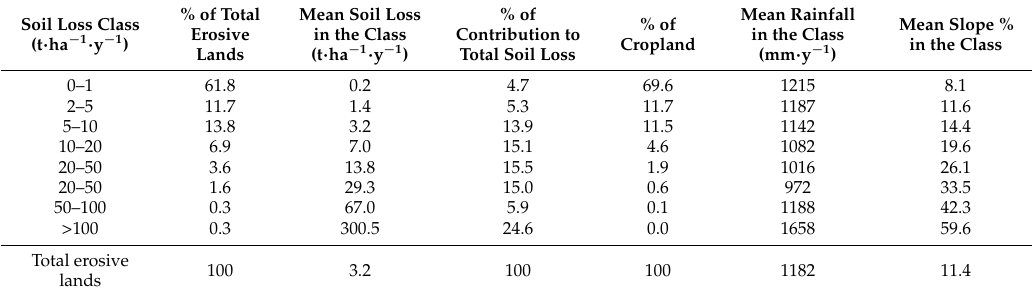
Table 3. The rates of estimated erosion risk per class (of entire erosive lands of 194,902.61 Km 2 ) corresponding to Figure 5b and focusing on the croplands, rainfall intensity, and slope